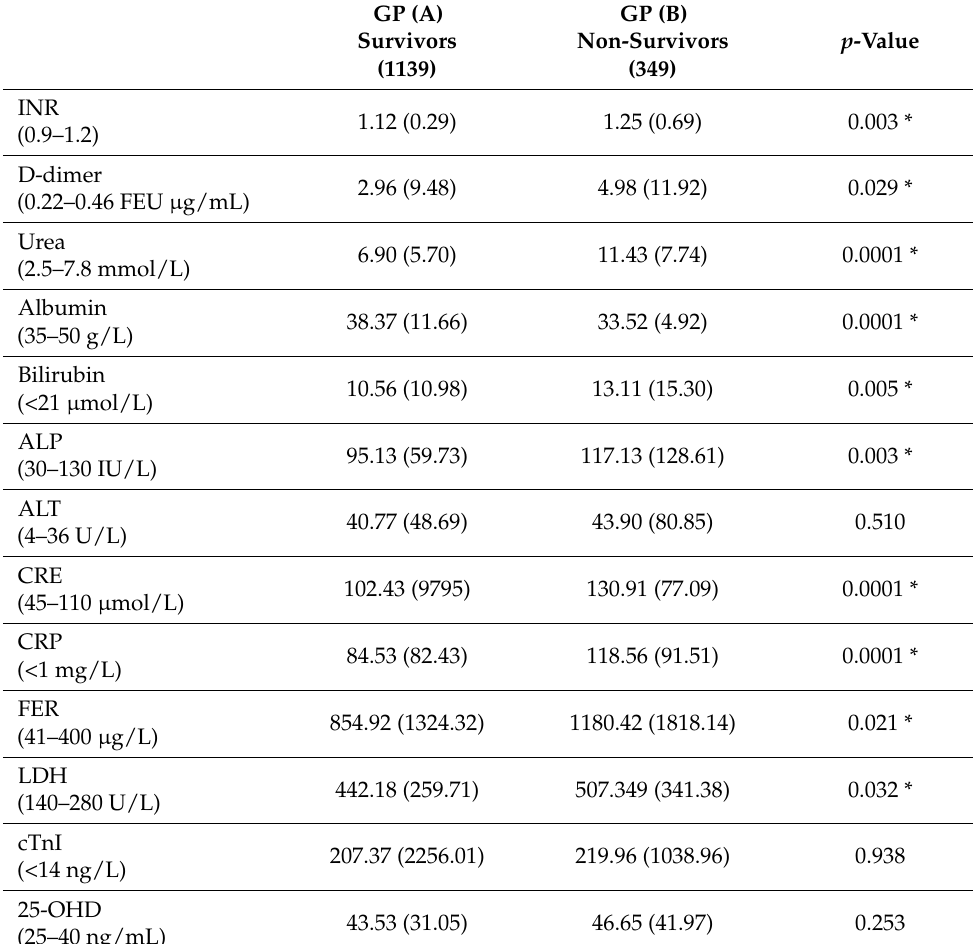
Table 3. Infection-related Clinical Complications Prognostic